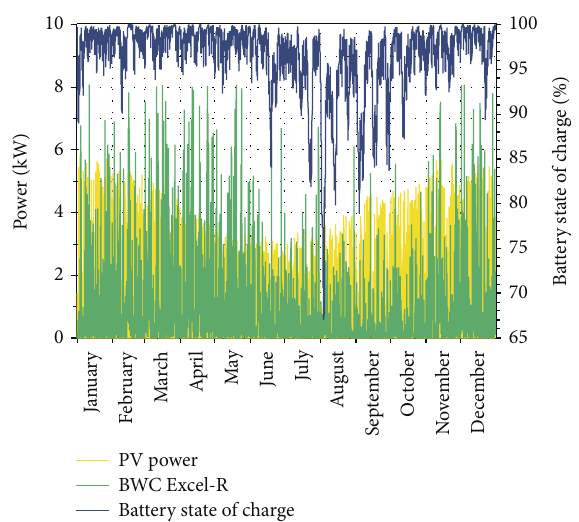
Figure 8: Integrated renewable energy (PV/Wind) versus battery state of charge.